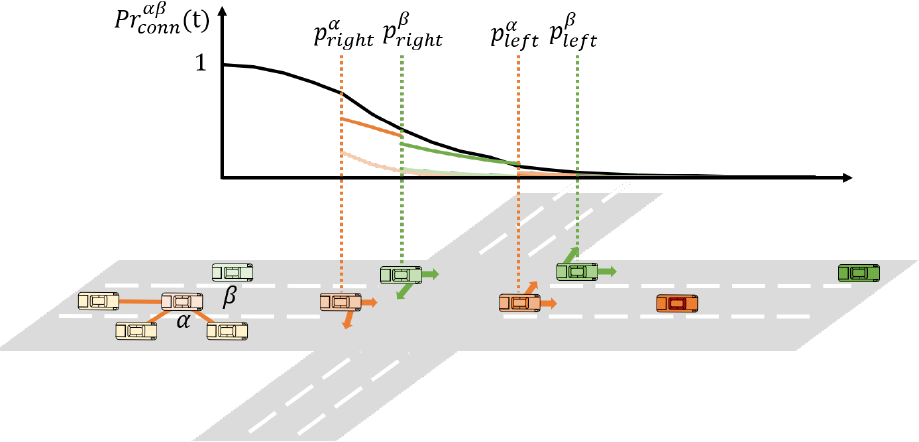
Figure 3. Probability of the connection in multiple